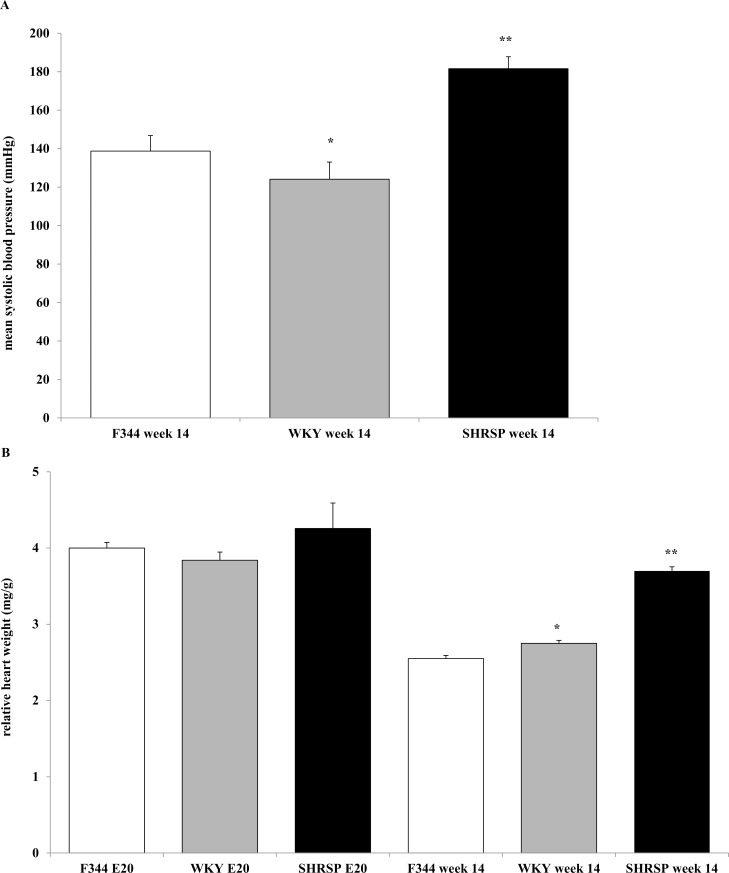
Mean systolic blood pressure and relative heart weight.Comparison of mean systolic blood pressure (panel A) and relative heart weight (panel B) between F344 strain (white bars, E20 n = 8, week 14 n = 8), WKY strain (grey bars, E20 n = 5, week 14 n = 17) and SHRSP (black bars, E20 n = 7, week 14 n = 1) at state E20 and at week 14, respectively. Values are means ± SD, * p < 0.05 vs. F344 at week 14, ** p < 0.05 vs. F344 and WKY at week 14, respectively.